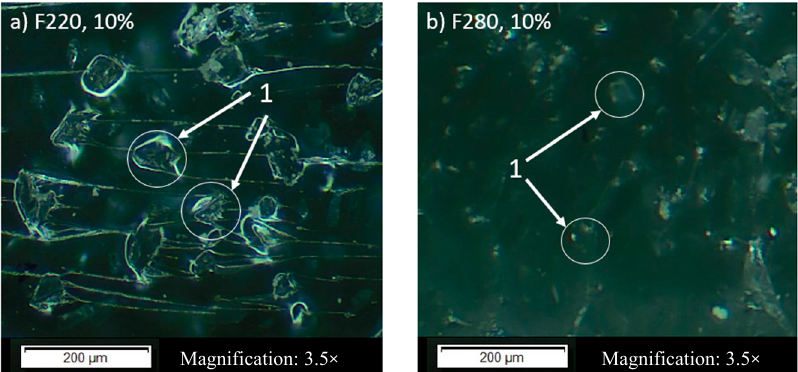
Figure 1. Fracture surfaces of epoxy composites with 10% mass share of alundum, ( a ) F220, ( b ) F280. 1 — grain of alundum.